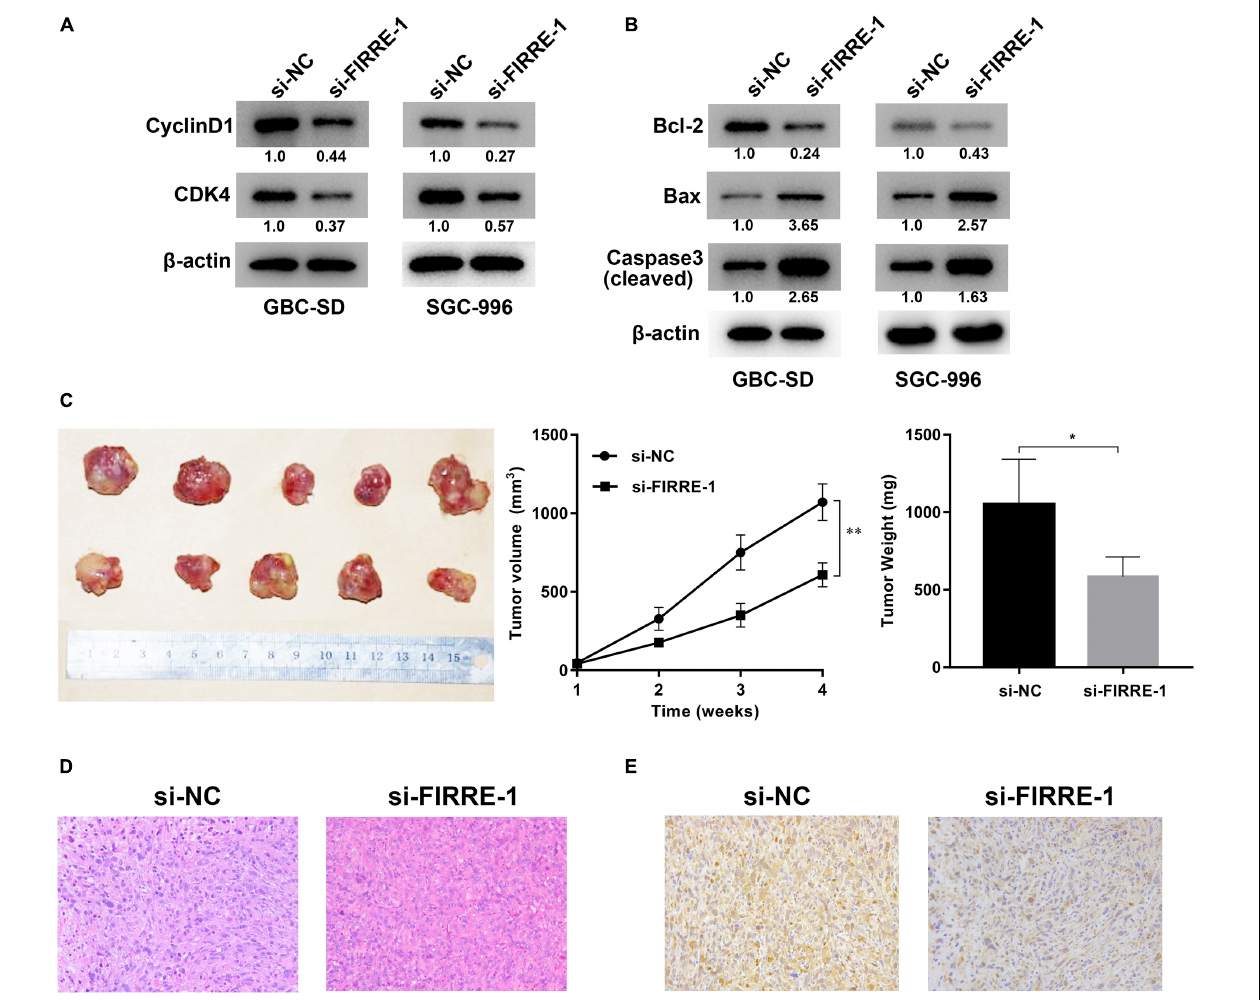
FIGURE 3 | Effect of FIRRE on the proteins related to cell cycle and apoptosis, and xenograft tumor growth in vivo . (A) The expression levels of cell cycle-related proteins CyclinD1 and CDK4 were determined by western blot assays transfected with si-FIRRE-1 in GBC-SD and SGC-996 cells. (B) The expression levels of apoptosis-related proteins Bcl-2, Bax, and Cleaved caspase-3 in transfected GBC-SD cells and SGC-996 cells. (C) Representative example of nude mice at 4 weeks post-injection with subcutaneous xenografts of GBC-SD cells transfected with si-FIRRE-1 (five mice per group). Quantitative analysis of xenografted tumor volumes and weights. (D) HE staining of tumor tissues transfected with si-NC or si-FIRRE-1. (E) The YOD1 protein levels of xenograft tumors from si-NC or si-FIRRE-1 groups was determined by immunohistochemical staining. * p < 0.05, ∗∗ p < 0.01.